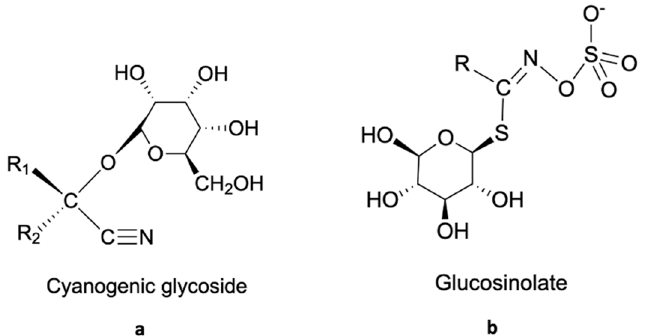
Figure 1. The general structure of ( a ) Cyanogenic glycoside and ( b ) Glucosinolate. The occurrence of CGs is more widespread across the Plantae region than GSLs [43].